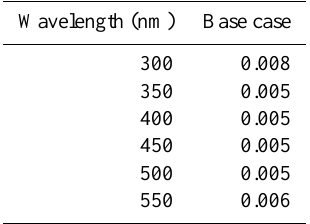
Table 2. Imaginary part of the refractive index ( k) values for the base case with weakly absorbing “colorless” primary organic car- bon.